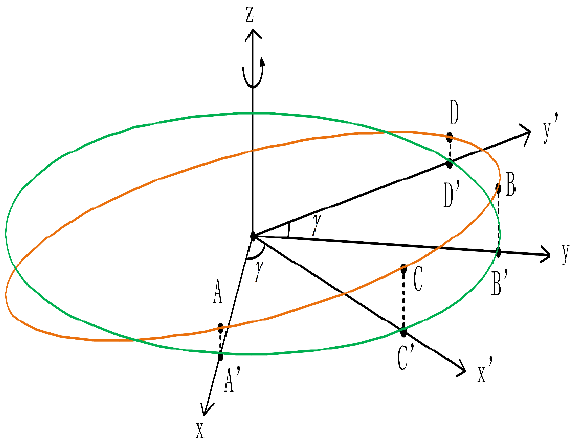
Figure 2. Sensor Coordinates. As shown in Figure 2, the FSM position coordinate system takes the Z-axis in the rectangular coordinate as the rotation axis, and the plane xoy is x (cid:48) oy (cid:48) after rotating γ around the Z-axis. Through the right-hand helix theorem, the right-hand helix direction is the positive direction of object rotation, that is, it is counterclockwise from the